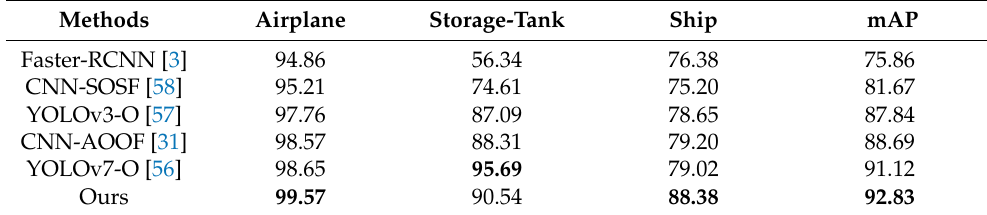
Table 4. Result on WHU-RSONE-OBB. The best result is bolded in each column.